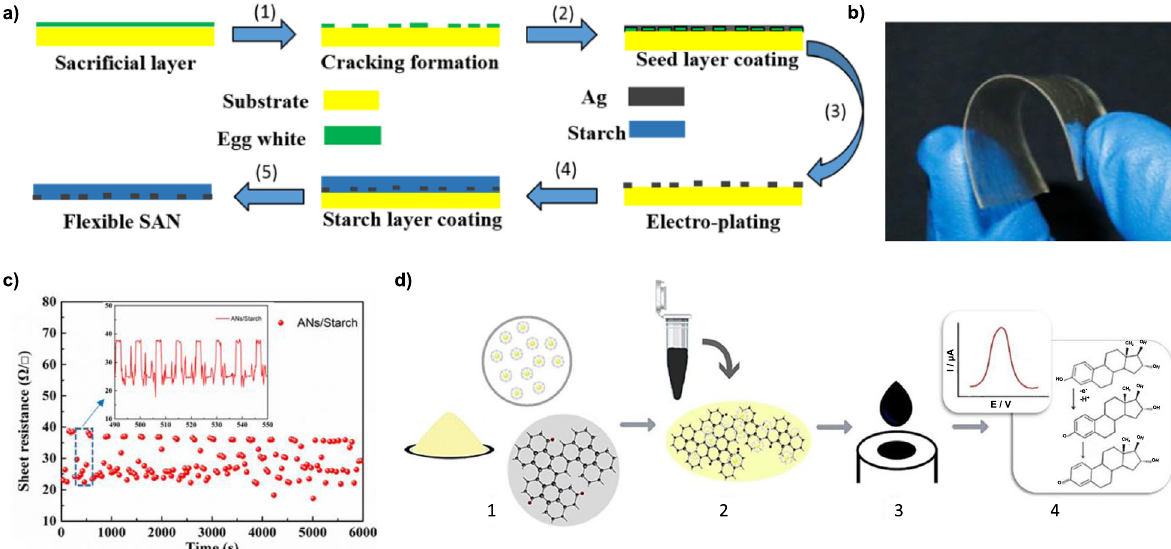
Fig. 3 Flexible strain and chemical sensors based on starch fi lms. a Fabrication processes and b fl exibility demonstration as well as c sheet resistance corresponding to bending times of a sensor based on starch-Ag networks (SANs). Reproduced with permission 86 . Copyright 2019, Springer. d Preparation protocol of the chemical sensor that detects estriol from RGO-GNPs-PS. Reproduced with permission 87 . Copyright 2017,